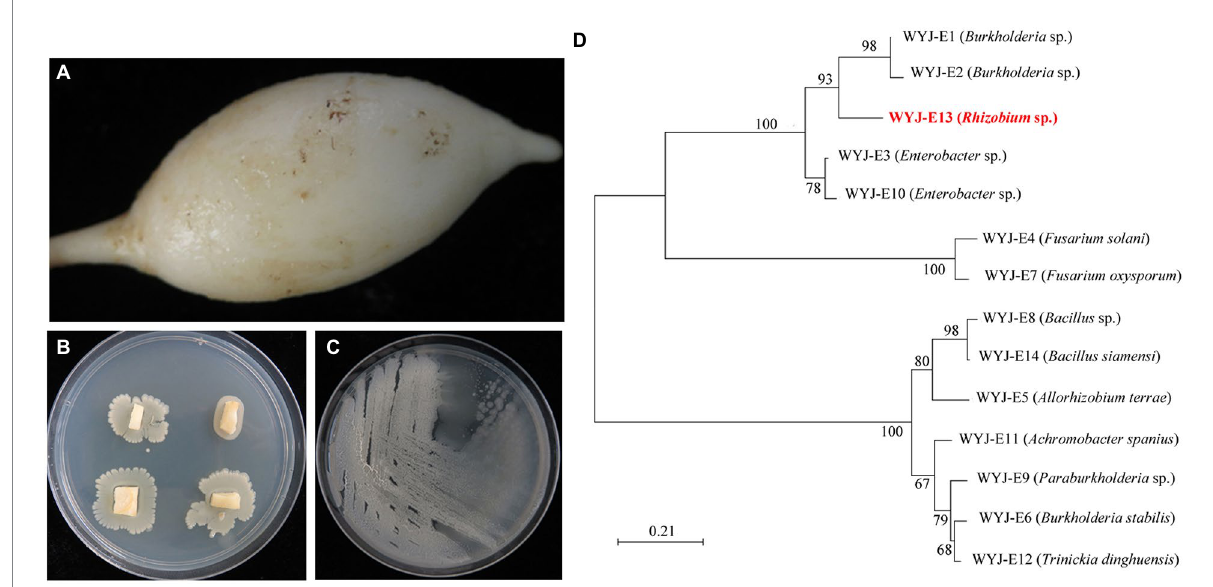
FIGURE 1 The isolation and characterization of endophytes isolated from the medicinal plant Curcuma wenyujin . (A) The tuberous root of medicinal plant Curcuma wenyujin . (B) The culture of endophytes on PDA medium. (C) The single-colony isolation of endophytes. (D) The phylogenetic tree of isolated 14 endophytes using MEGA X software.